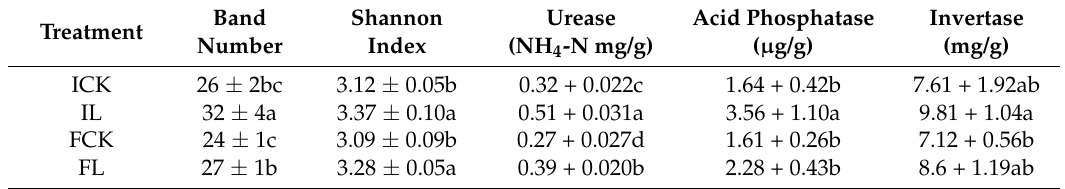
Table 4. Soil enzyme activities and microbial diversity index values for different